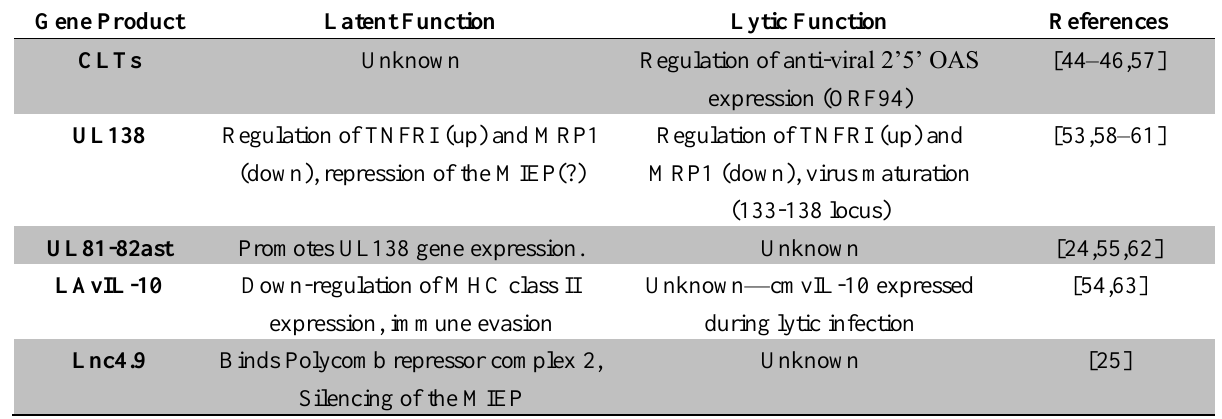
Table 1. Gene products and functions during latency and lytic